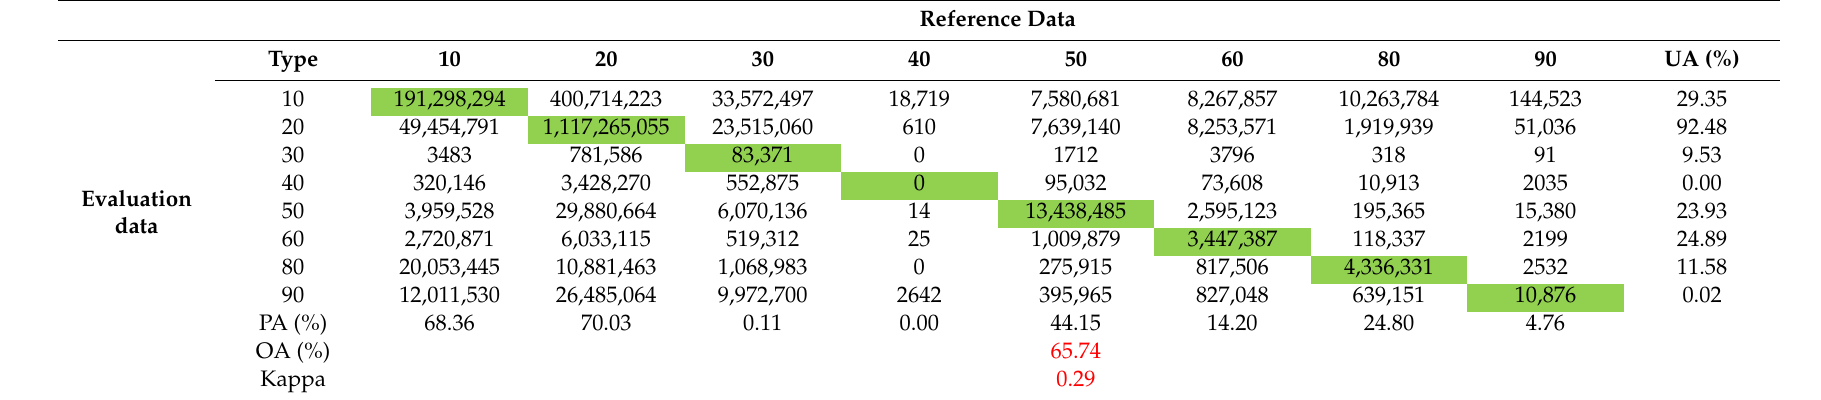
Table 8. Confusion matrix between GLC_FCS30-2015 and GlobeLand30-2010 (GLC_FCS30-2015 provides the reference